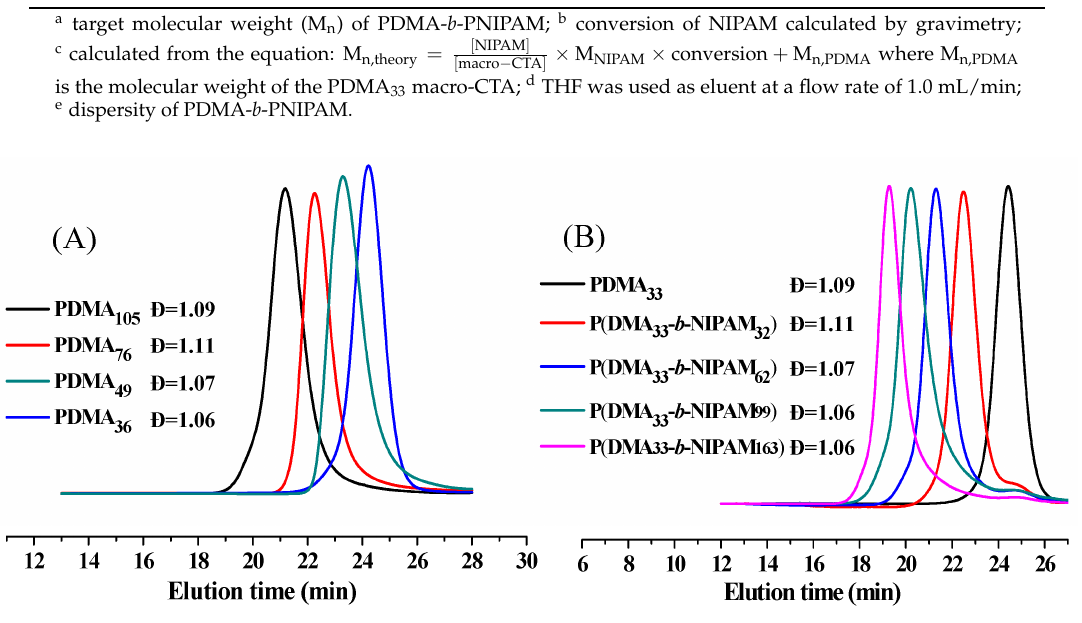
Figure 2. Gel permeation chromatography (GPC) traces of homopolymer or diblock copolymer eluted by THF. ( A ) macro-RAFT agent of PDMA-S-(C=S)-S-C 12 H 25 with different degree of polymerization; ( B ) P(DMA- b -NIPAM)-S-(C=S)-S-C 12 H 25 copolymers prepared with the molar ratios of NIPAM/PDMA 33 -S-(C=S)-S-C 12 H 25 at 43:1, 80:1, 140:1 and 250:1. Polymerization conditions: PDMA 33 -S-(C=S)-S-C 12 H 25 :[AIBN] = 7:1, 65 ◦ C, 20